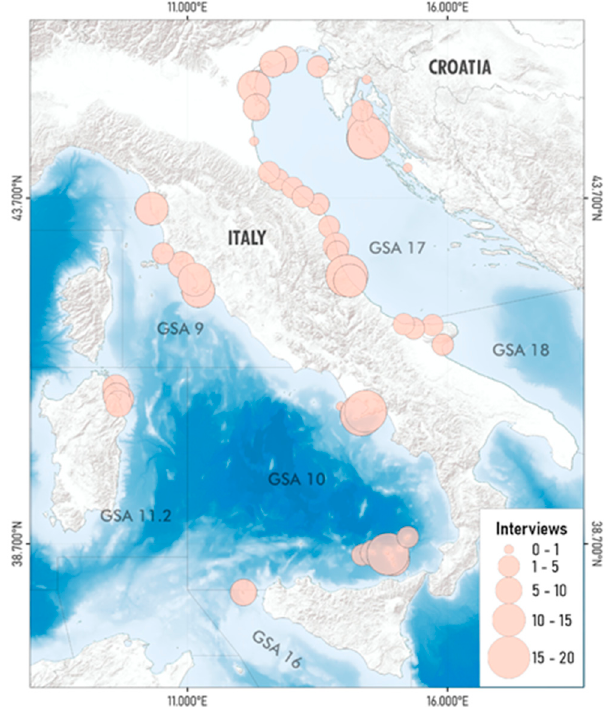
Figure 1. Study area. The orange circles indicate the number of respondents by